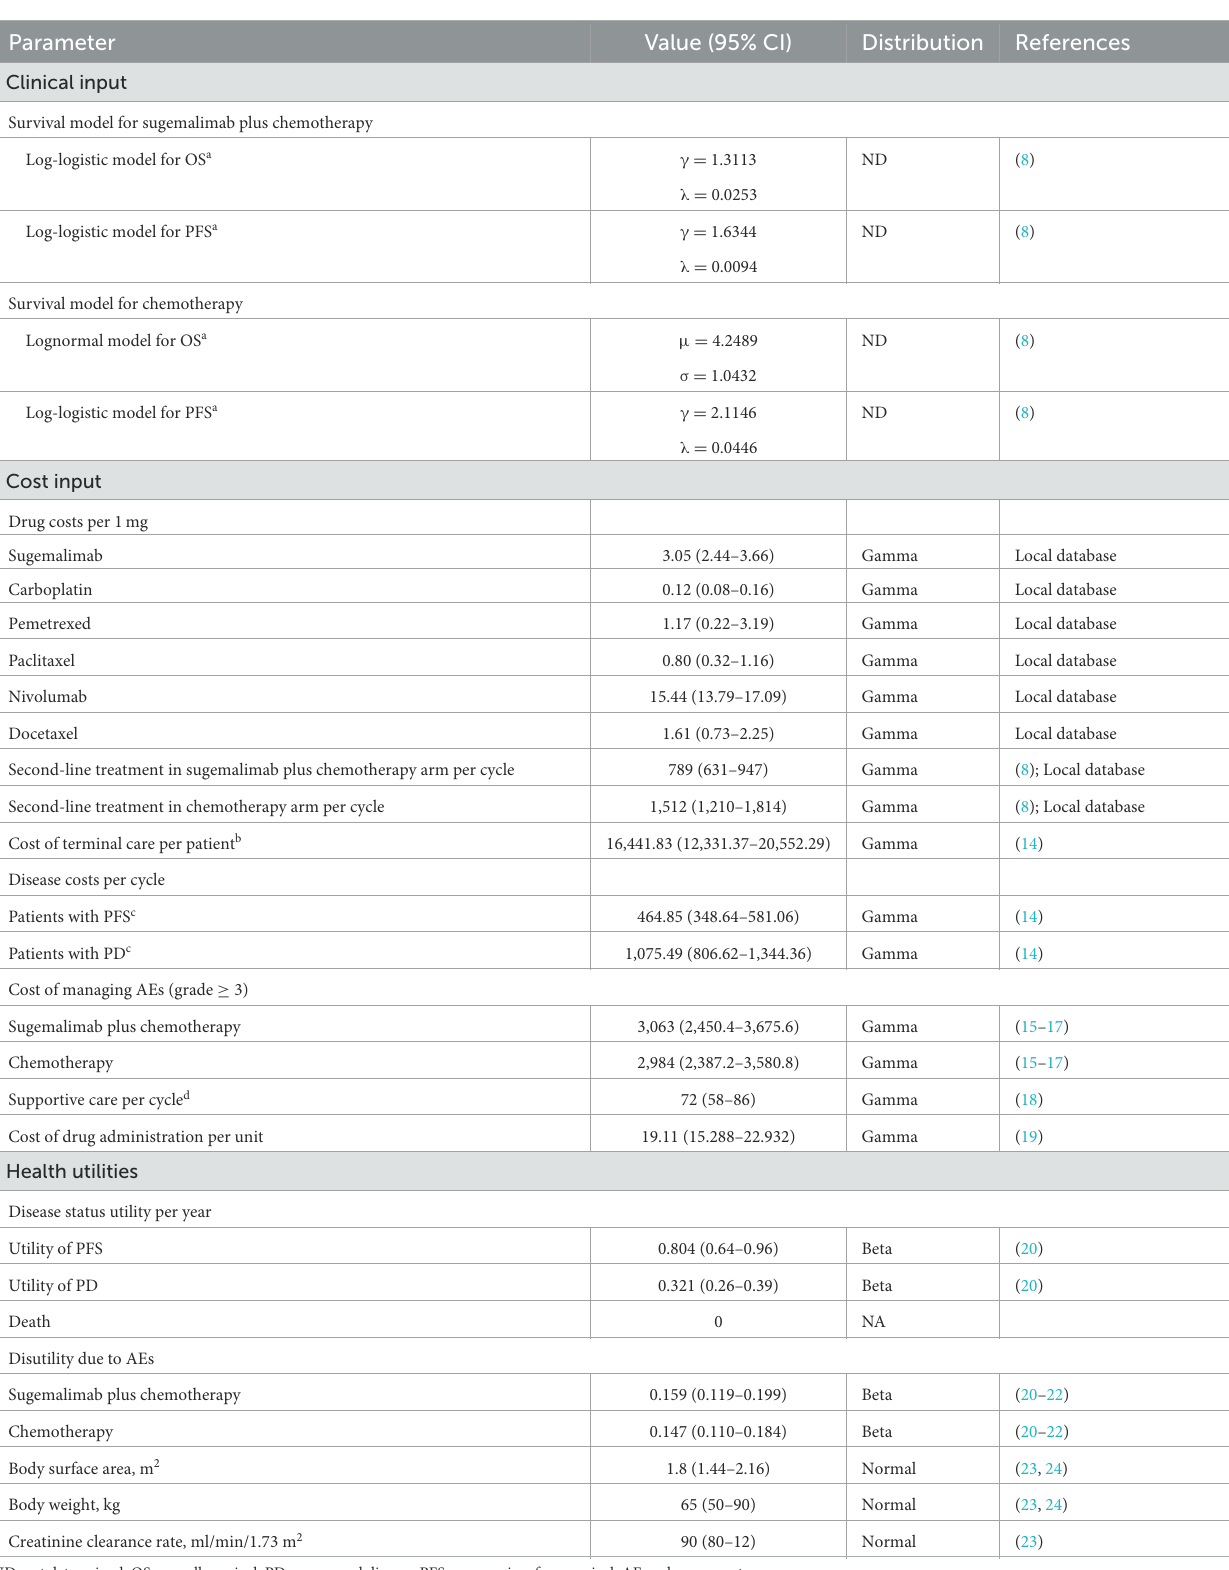
TABLE 1 Key model